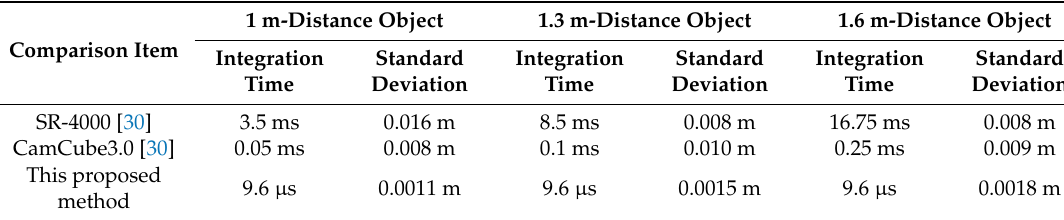
Table 1. Standard deviations of conventional cameras and the proposed